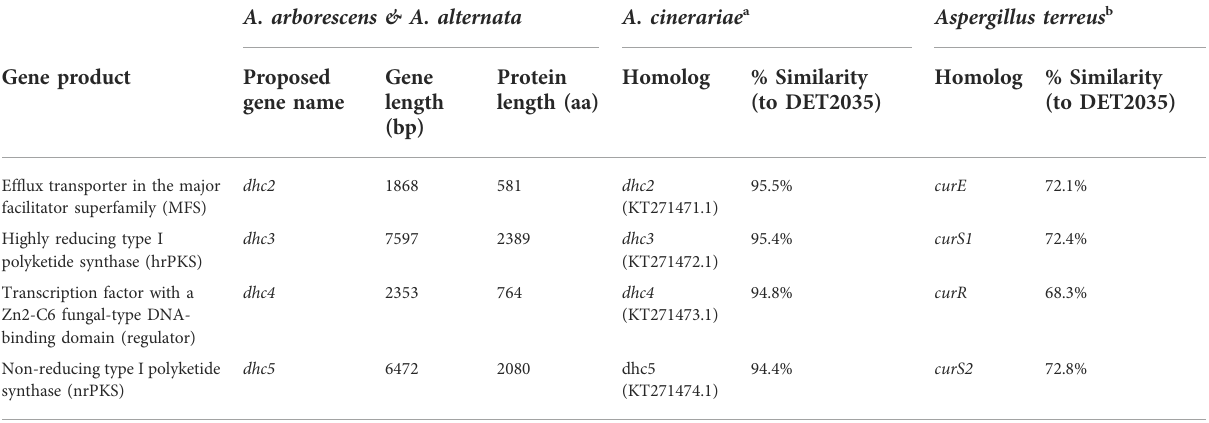
TABLE 3 Description and sequence homology comparison of four core genes involved in dehydrocurvularin (DHC) biosynthesis as observed from A. arboresecens and A. alternata strains and compared with published sequences from A. cinerariae and Asp. terreus